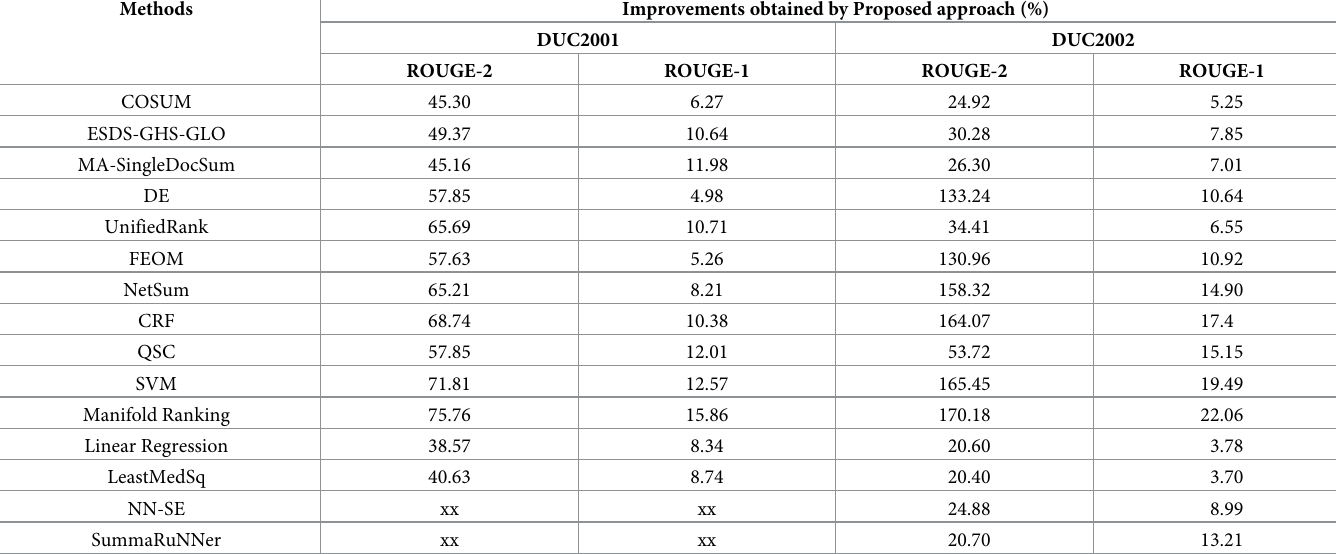
Table 8. Improvements attained by the proposed approach, Approach-1 (WMD) with SOM based operators over other methods considering ROUGE scores. Here, xx indicates non-availability of results on the DUC2001 dataset.